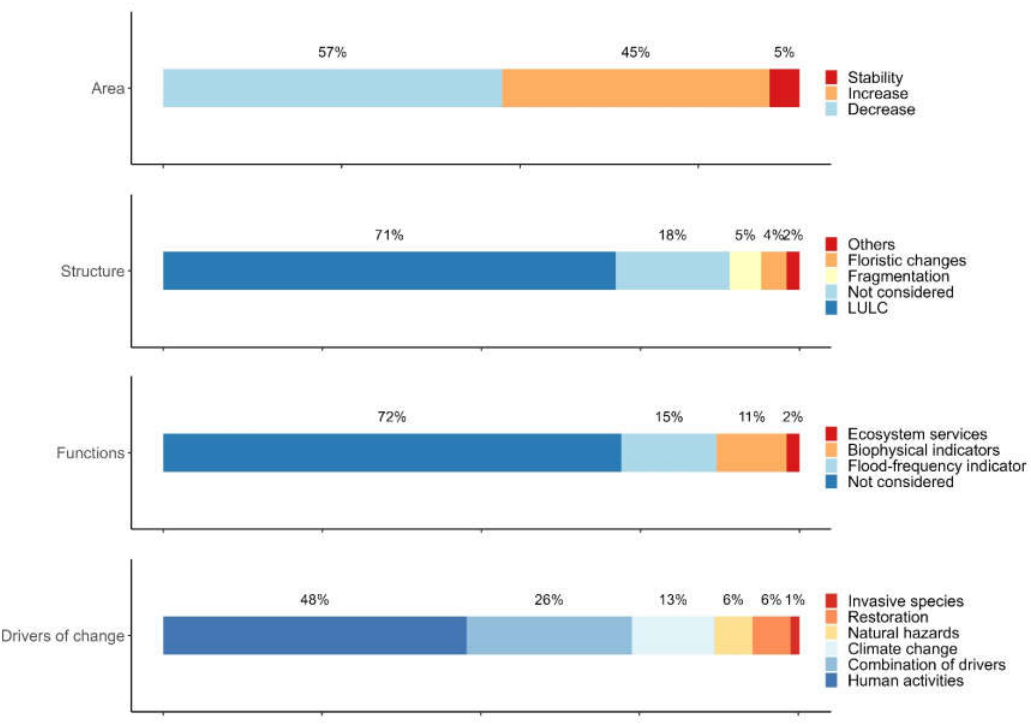
Figure 5. Distribution of the reviewed studies according to categories of long-term wetland